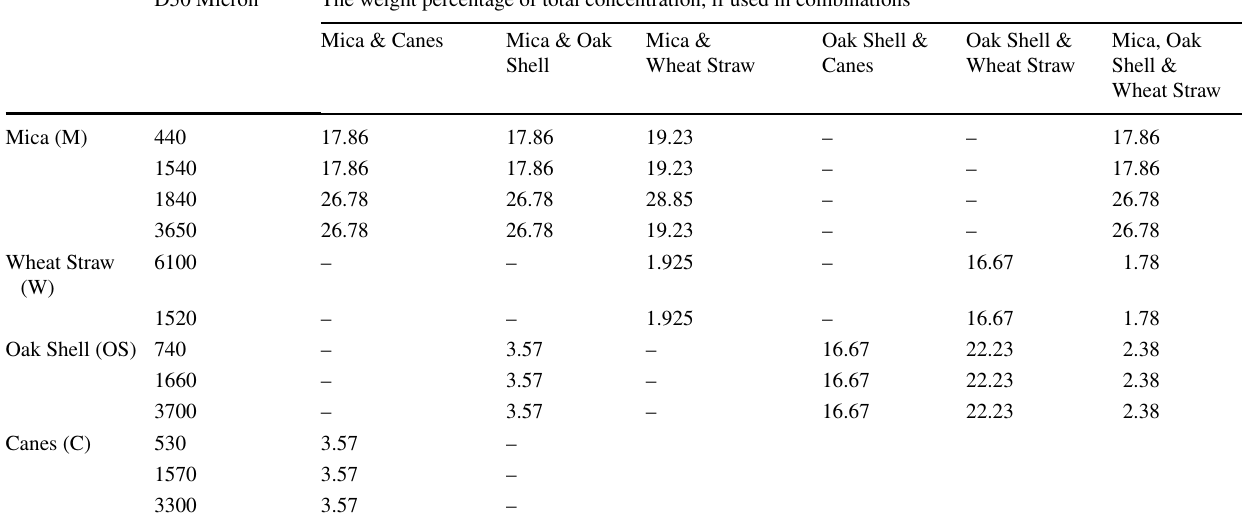
Table 11 LCM's concentration and PSD, when used in combinations